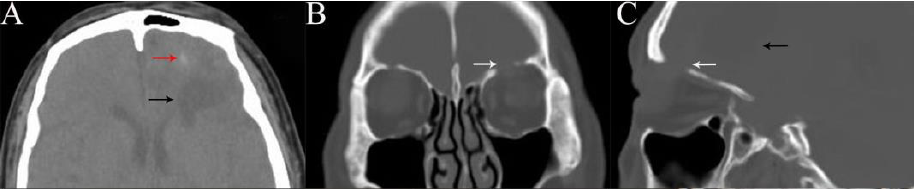
Figure 2. Head computed tomography (CT) scan showed a short, strip-like, slightly high-density shadow (red arrow) and a cystic mass (black arrow) in the left frontal lobe, and a fracture of the left superior orbital wall (white arrow). Axial ( A ), coronal ( B ), and sagittal views ( C ).